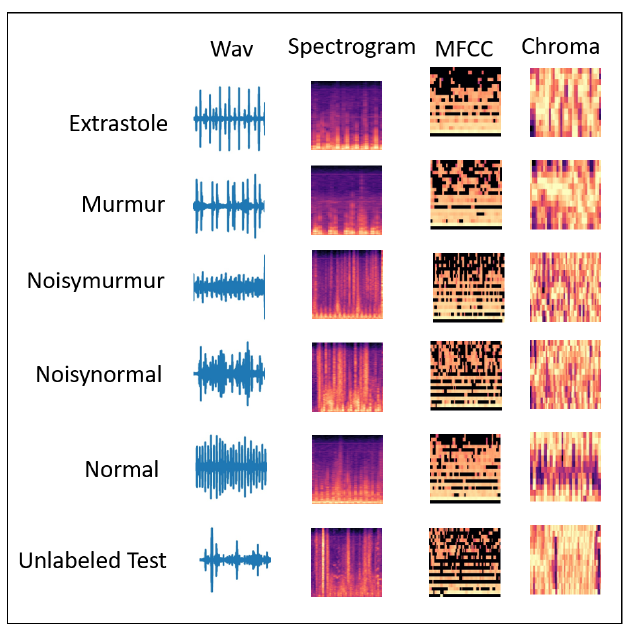
Figure 3. Heart Sound Features: (1) Wav (2) Spectrogram (3) MFCC (4)